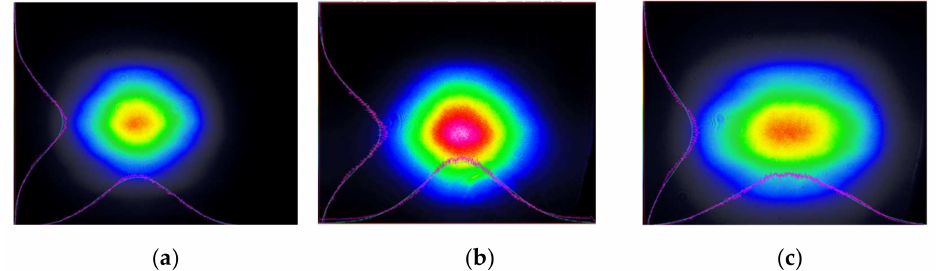
Figure 5. The beam profiles of seeds at different pump powers. ( a ) Beam profile of the seed with a pump power of 2.4 W (the circularity was 0.876). ( b ) Beam profile of the seed with a pump power of 3.3 W (the circularity was 0.829). ( c ) Beam profile of the seed with a pump power of 3.9 W (the circularity was 0.776).